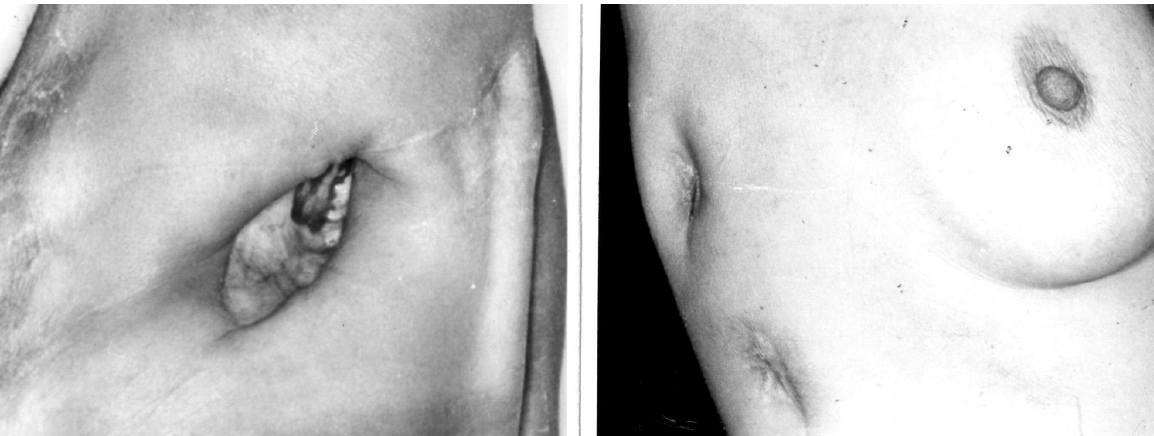
Figure 4 - On the left, a conventional open pleural window scar in a male patient. On the right, the upper scar is after POP removal, and below is a scar after removal of a regular 36 FR chest